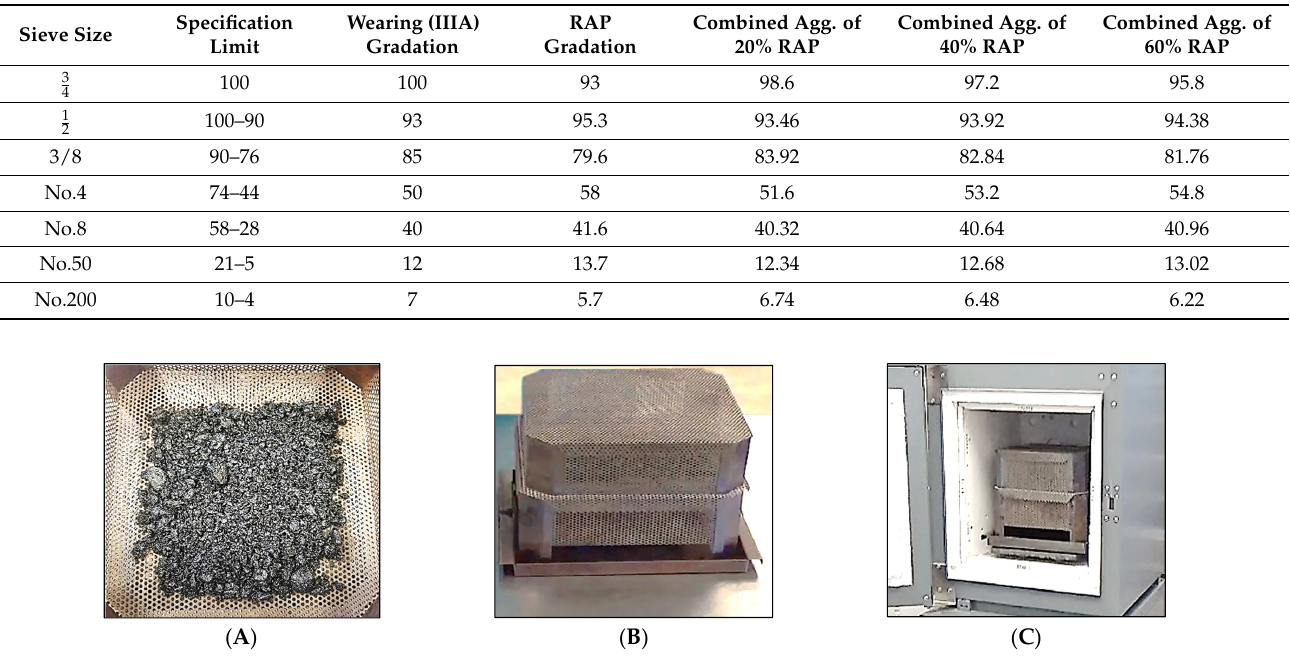
Table 4. The gradation of virgin aggregate, RAP, and combined aggregate.